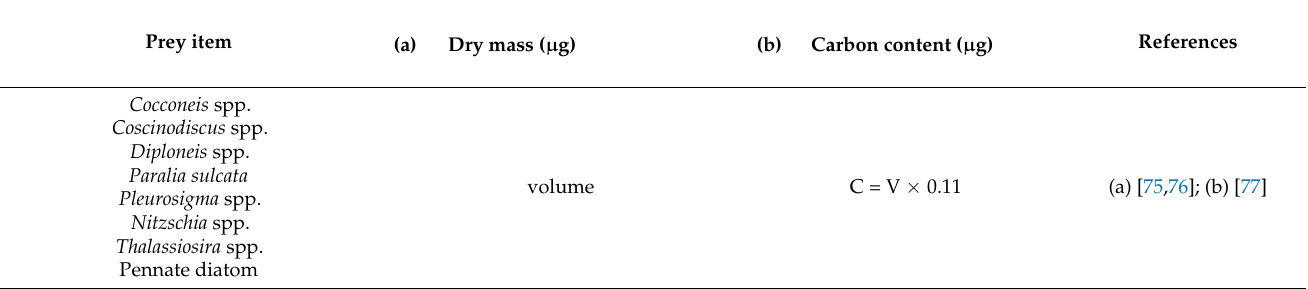
Table A1. Morphometric relationships used to calculate (a) dry mass (DM) ( µ g) and (b) carbon content ( µ g C) of Sardina pilchardus preys. PL: prosome length ( µ m); L: total length ( µ m); V: volume. Brackets (a) and (b) indicate which sources the relationships refer